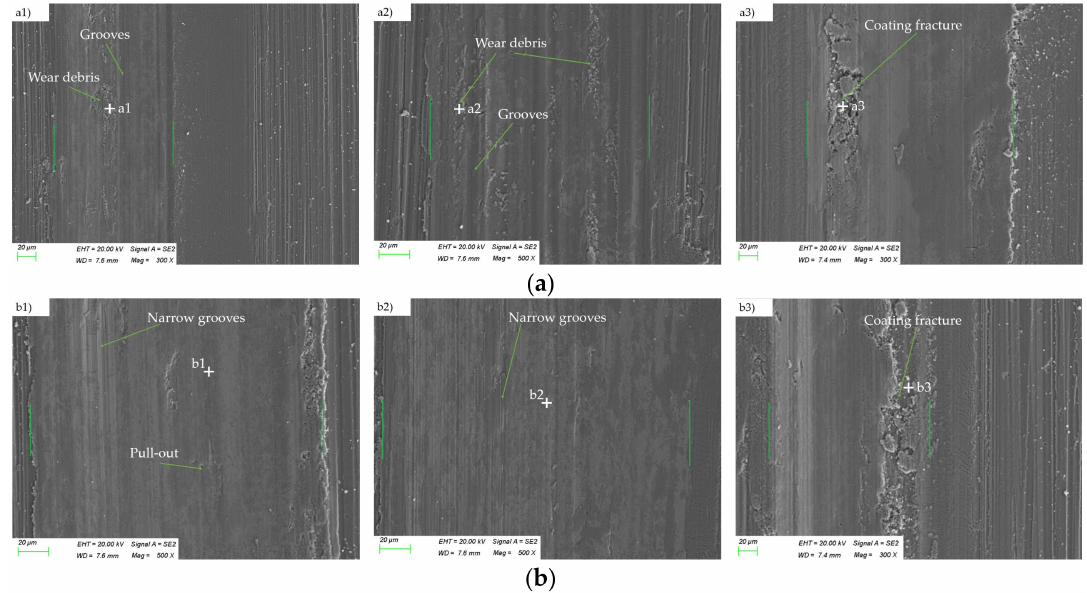
Figure 10. Morphology of the worn tracks on 2 µ m CrN coated M50 disks: ( a ) at the temperature of 25 ◦ C under the load of ( a1 ) 10 N, ( a2 ) 15 N, and ( a3 ) 25 N; and ( b ) at the temperature of 200 ◦ C under the load of ( b1 ) 10 N, ( b2 ) 15 N, and ( b3 ) 25 N. Table 4. The EDS analysis results corresponding to the positions in Figure 10.